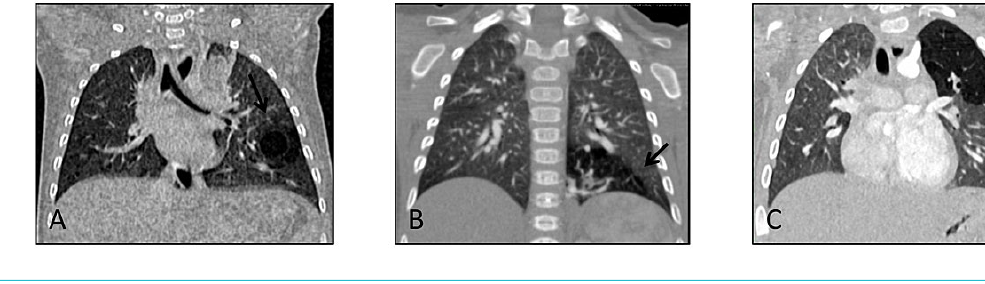
Figure 3: Thoracic computed tomography (CT) scans of paediatric patients with congenital lung anomalies. Coronal cuts of thoracic CT scans performed between the ages of 4 and 6 months. Black arrows point at the lesion on each picture. A. Congenital pulmonary airway malformation. B. Bronchopulmonary sequestration. C. Congenital lobar segmental